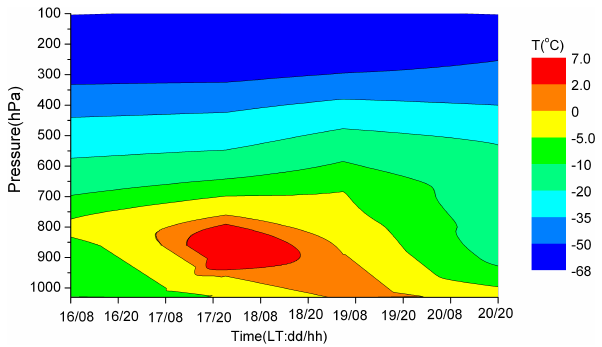
and NO at (a) BJ and (b) SDZ from 14 to 23 2 3 2